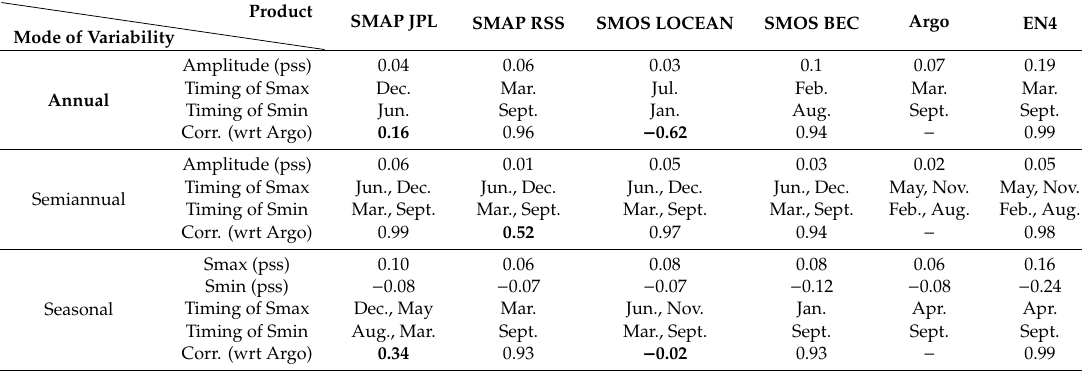
Figure 9. The seasonal variations (i.e., the combination of the annual and semiannual cycles). averaged over the five selected boxed areas depicted in Figure 1b and the entire basin. ( a ) Box 1. LS: The Labrador Sea. ( b ) Box 2. IS:The Irminger Sea. ( c ) Box 3. NS: The Nordic Seas. ( d ) Box 4. SPG: The Subpolar Gyre. ( e ) Box 5. NFL: Newfoundland. ( f ) The entire subpolar North Atlantic basin. Table 1. Parameters of the estimated annual, semiannual, and seasonal (annual + semiannual) variability for the period of 2016–2018. The parameters listed in the table include amplitude, timing of SSS maximum (denoted Smax), timing of SSS minimum (denoted Smin), and correlation coe ffi cient with respect to Argo. The correlation coe ffi cients in bold indicate that they were not statistically significant at the confidence interval of